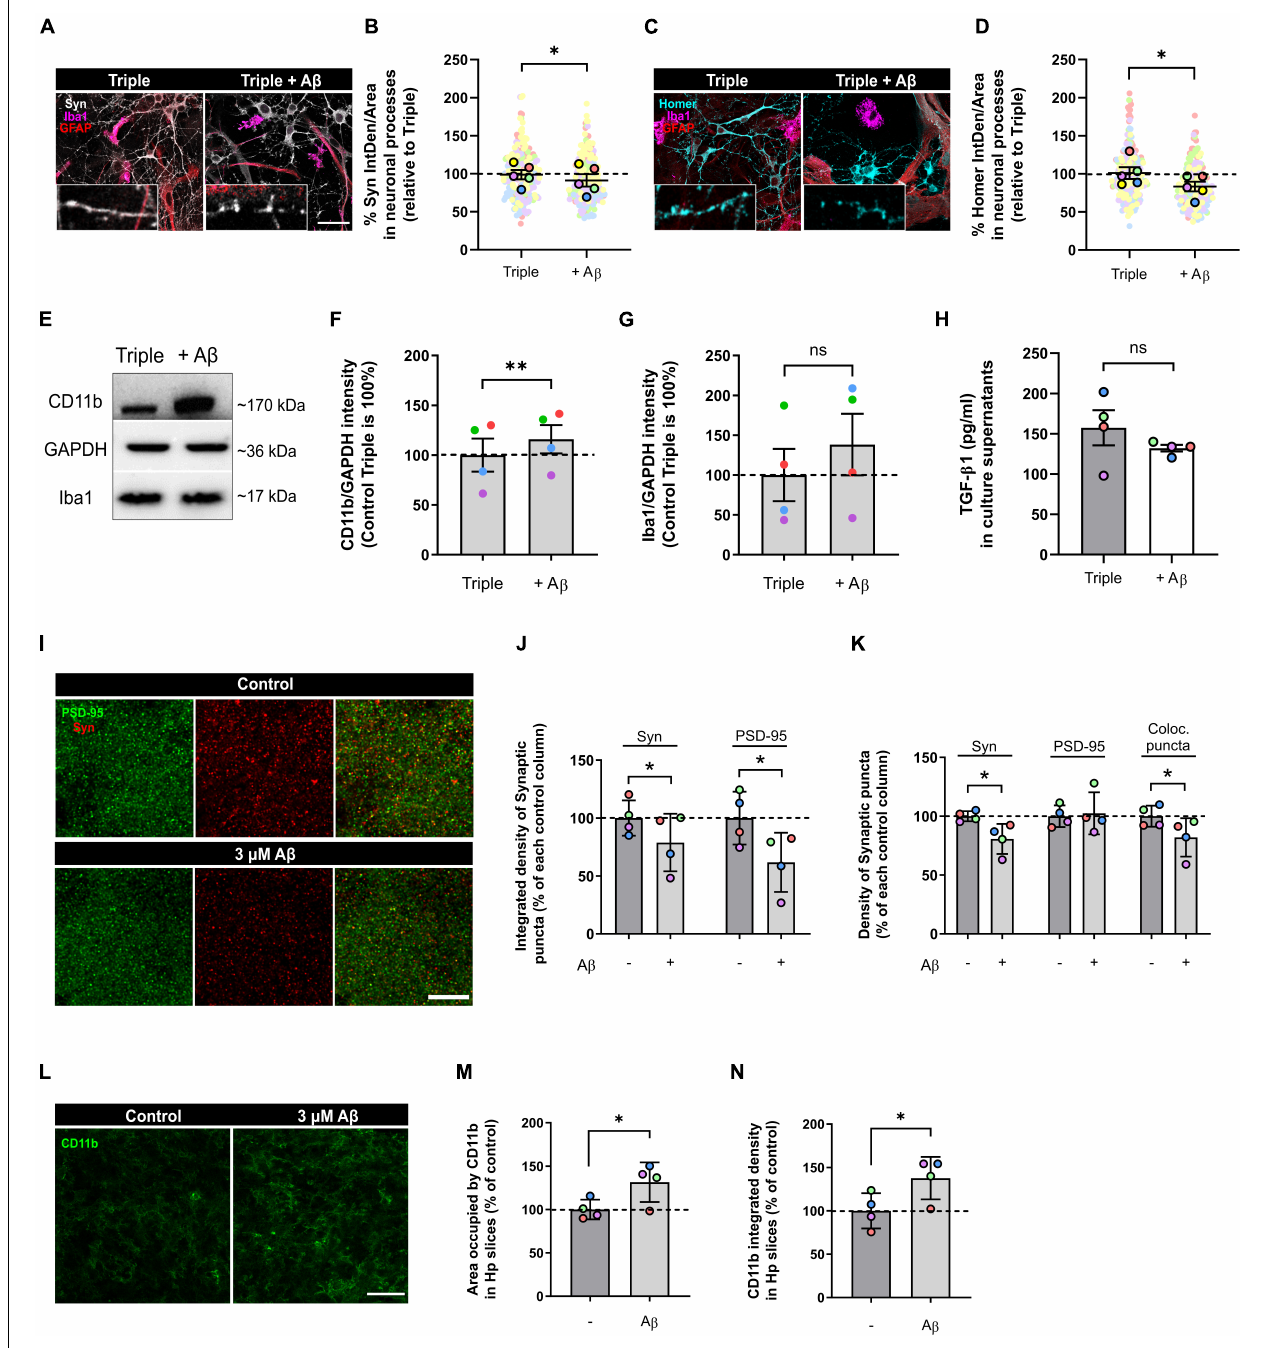
FIGURE 4 | Oligomeric A β reduced pre- and post-synaptic puncta and increased microglial expression of CD11b in the triple co-culture and in hippocampal organotypic slices. (A) Representative image of Synaptophysin in neuronal processes. Scale bar = 40 µ m. (B) Quantification of Synaptophysin in the triple co-culture after oA β treatment ( n = 5). (C) Representative image of Homer1 in neuronal processes. Scale bar = 40 µ m. (D) Quantification of Homer1 in the triple co-culture with oA β ( n = 5). (E) Western blot image of microglial markers in total lysates. (F) Quantification of CD11b in the triple co-culture ( n = 4). (G) Quantification of Iba1 expression ( n = 4). Raw data was normalized with GAPDH. (H) ELISA quantification of TGF- β 1 in culture supernatants ( n = 4). (I) Representative images of synaptic markers puncta in hippocampal organotypic slices. Scale bar = 10 µ m. (J) Integrated density of Synaptophysin and PSD-95 in organotypic cultures after oA β treatment ( n = 4). (K) Quantification of the puncta density of Synaptophysin, PSD-95 and the colocalization of both markers ( n = 4). (L) Representative image of CD11b staining in hippocampal organotypic slices. Scale bar = 40 µ m. (M) Area occupied by CD11b staining after oA β treatment ( n = 4). (N) Integrated density of CD11b ( n = 4). Each bar represents the mean ± SEM. * p < 0.05; ** p < 0.01; ns, not significant. For quantification, 5–6 random fields and 4 random fields per condition were quantified in triple co-cultures and organotypic cultures, respectively. Syn,